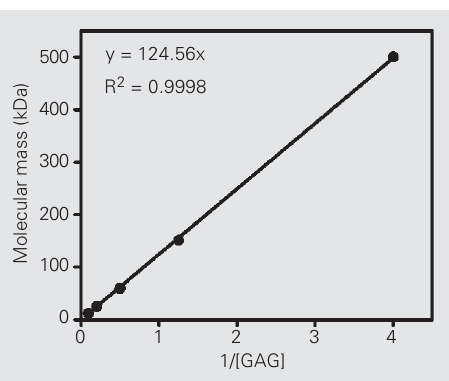
Figure 5. Linear inverse ratio be- tween the concentration of the assayed glycosaminoglycans (GAG) that gave the maximal modification of the DPP-IV K M when assayed in the superna- tant of S17 cells and their molec- ular